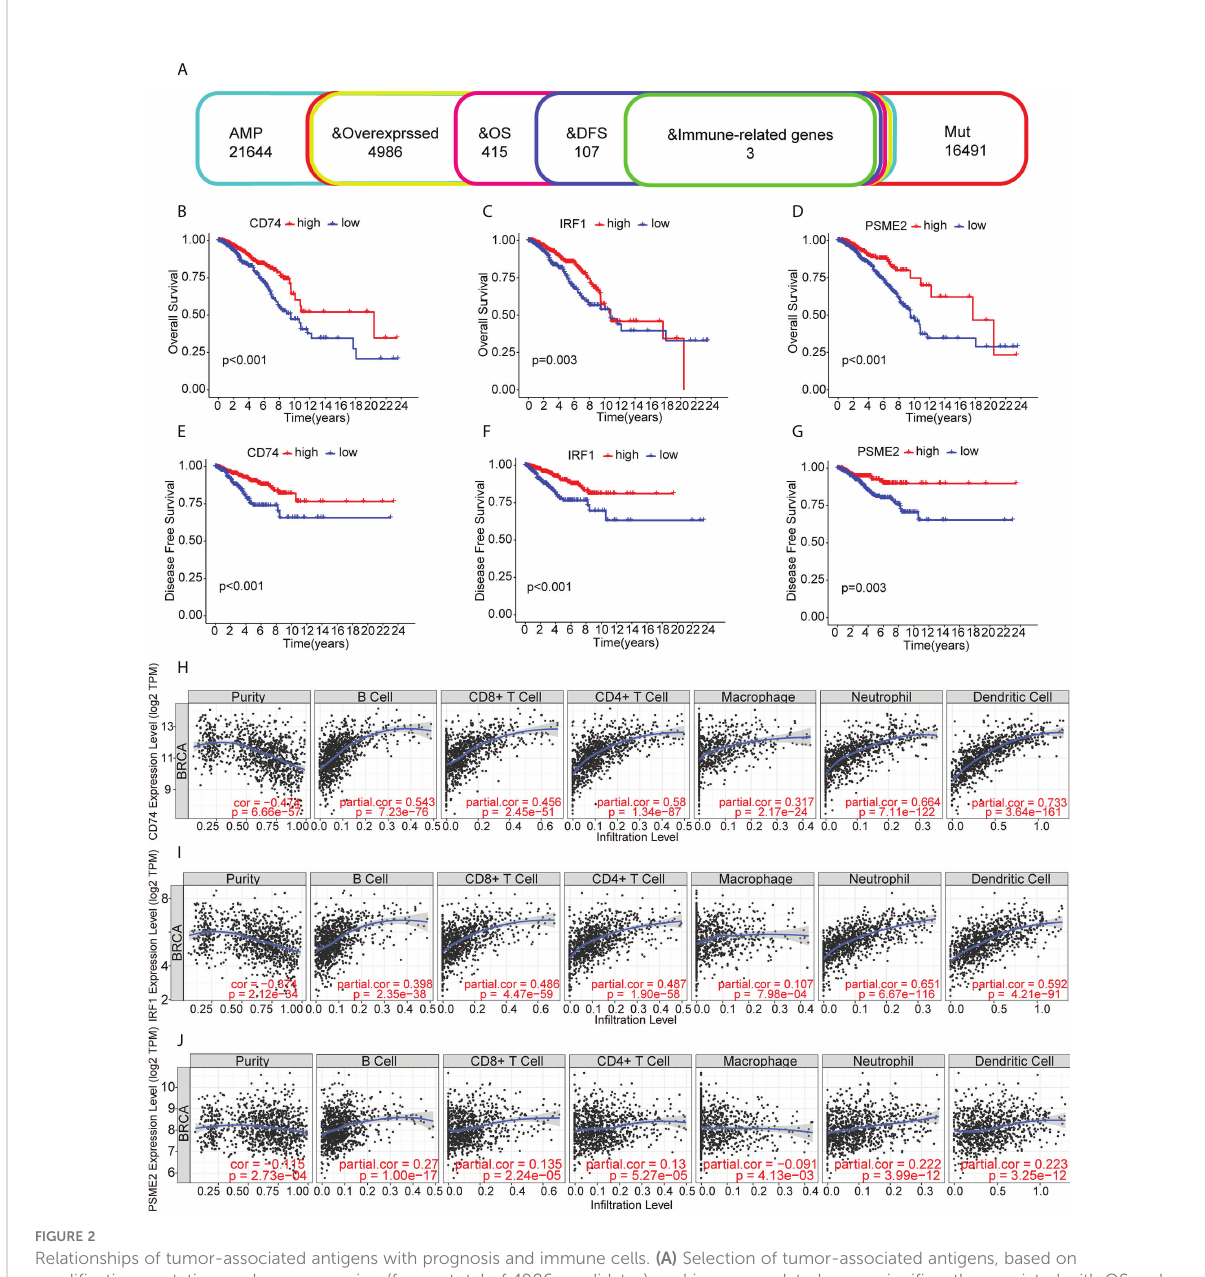
FIGURE 2 Relationships of tumor-associated antigens with prognosis and immune cells. (A) Selection of tumor-associated antigens, based on ampli fi cation, mutation, and overexpression (from a total of 4986 candidates), and immune-related genes signi fi cantly associated with OS and DFS (total of three candidates). (B-D) Kaplan-Meier OS curves for groups with different levels of CD74 (B) , IRF1 (C) , and PSME2 (D) . (E) Relationships between CD74 levels and the immune cell proportions and numbers of B cells, CD8+ T cells, CD4+ T cells, macrophages, neutrophils, and dendritic cells. (E-G) Kaplan-Meier DFS curves for groups with different levels of CD74 (E) , IRF1 (F) , and PSME2 (G) . (H) Relationship between CD74 levels and immune cell proportions and numbers of B cells, CD8+ T cells, CD4+ T cells, macrophages, neutrophils, and dendritic cells. (I) Relationship between IRF1 levels and immune cell proportions and numbers of B cells, CD8+ T cells, CD4+ T cells, macrophages, neutrophils, and dendritic cells in BC. (J) Relationships between PSME2 levels and the immune cell proportions and numbers of B cells, CD8+ T cells, CD4+ T cells, macrophages, neutrophils, and dendritic